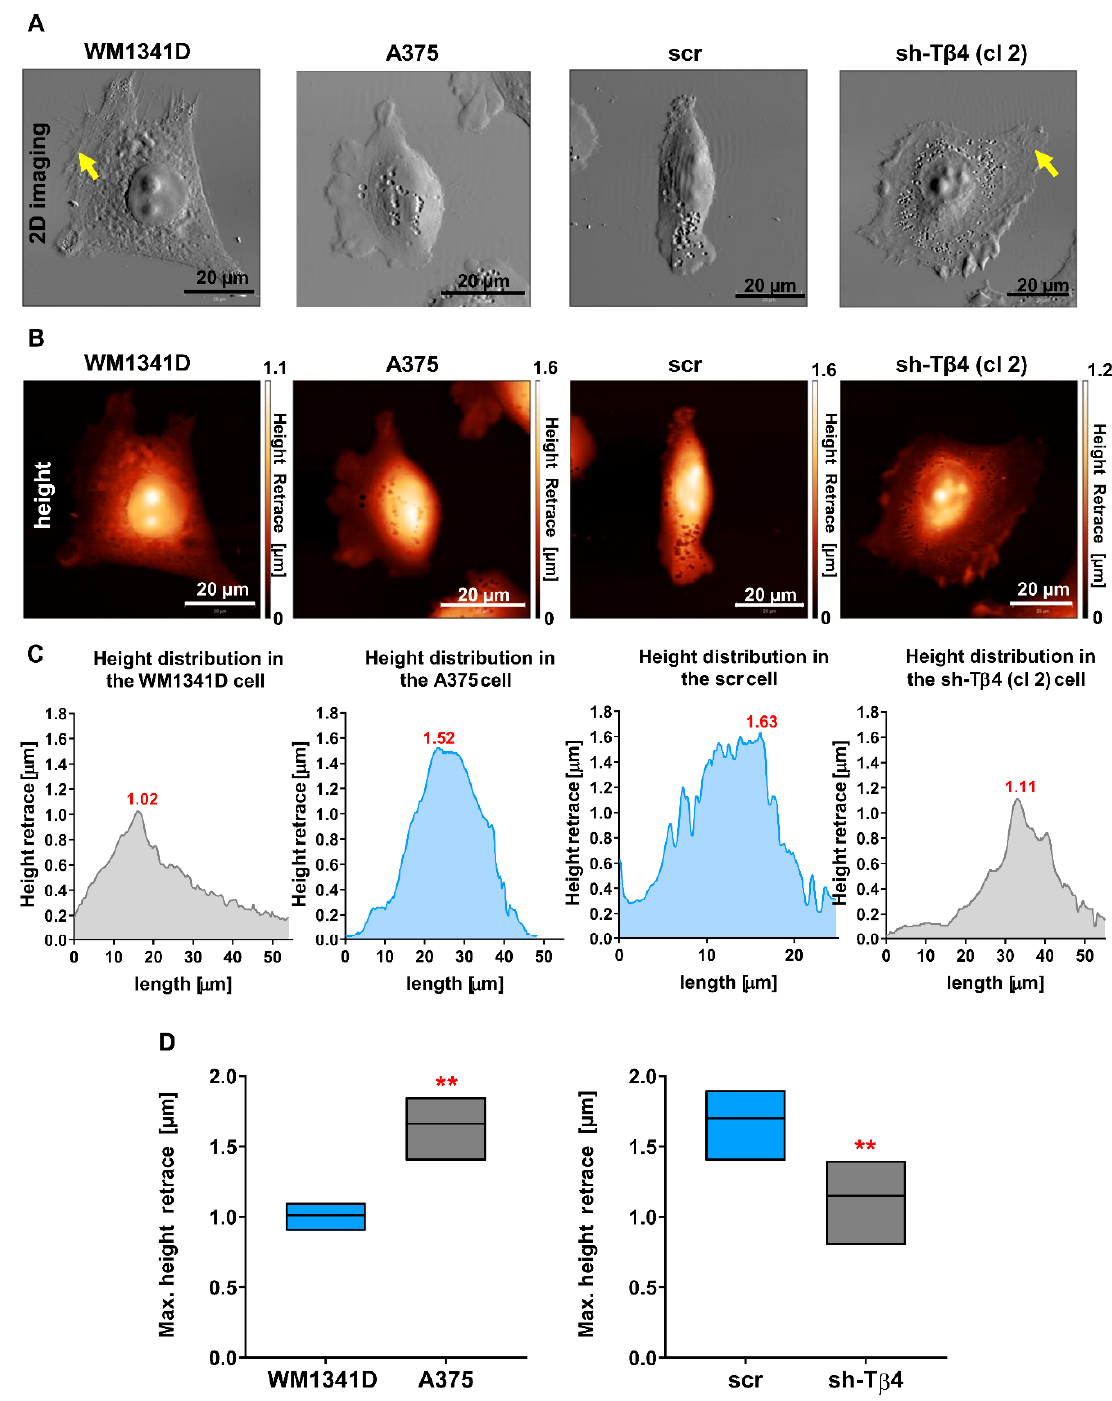
Figure 7. T β 4 influences melanoma cell morphology. ( A ) 2D visualization as a grayscale map of the cell surface of tested melanoma cells using the atomic force microscopy (AFM). Yellow arrows point at filamentous structures. ( B ) WM1341D, A375, scr, and sh-T β 4 cells’ body height measurements by AFM. The data obtained from the height measurements were visualized by a heat map (height retrace) of the cell body. The black color corresponds to 0 µm, passes through various red and yellow shades, and the highest point of the tested object is marked with white. ( C ) Histograms present the difference in the height of the cells shown in A-B in correlation to a drawn line’s position across the cell. ( D ) Graphs are illustrating the maximal height of the cells ( n = 5–10). Graphs indicate average-max-min values. The significance level was set at ** p < 0.01. The results presented separately for every clone are shown in Supplementary Figure S15D.